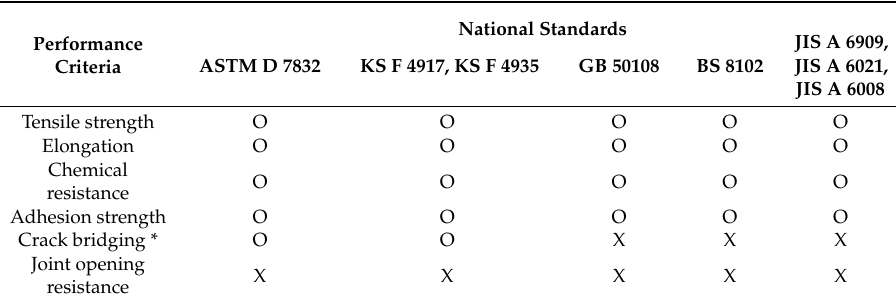
Table 3. Standards related to waterproofing membrane